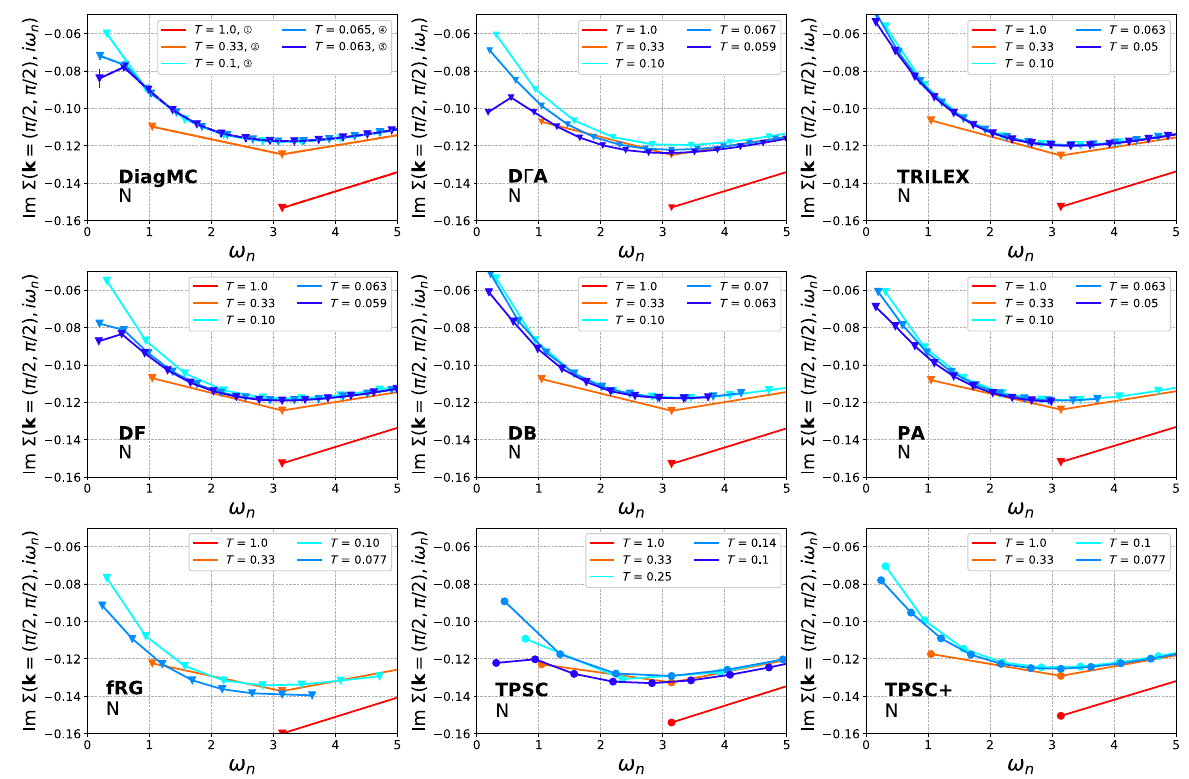
FIG. 11. Imaginary parts of the self-energies at the node as a function of Matsubara frequencies calculated by various many-body methods. Note that the lowest temperatures shown sometimes differ for the respective methods in order to show as many of the respective temperature regimes as